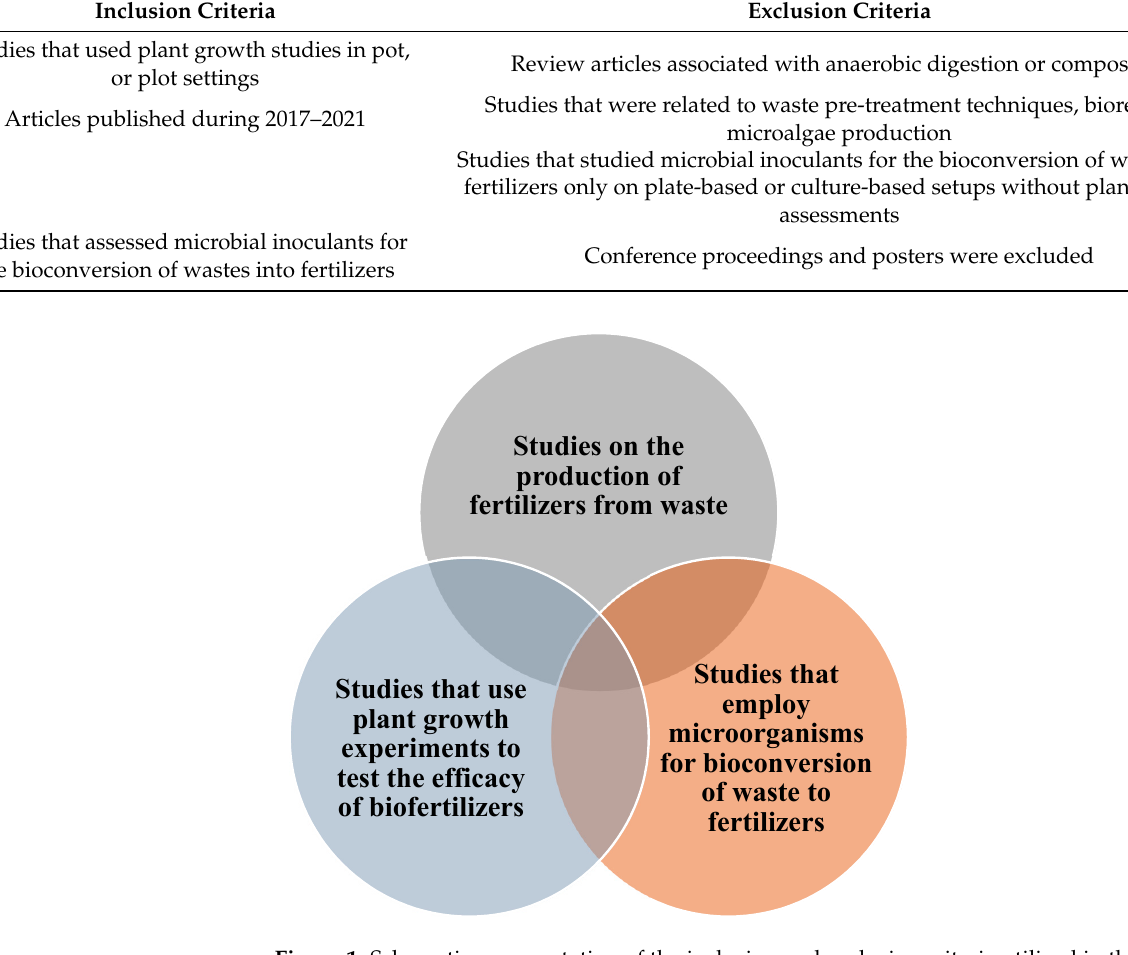
Figure 1. Schematic representation of the inclusion and exclusion criteria utilized in this study.